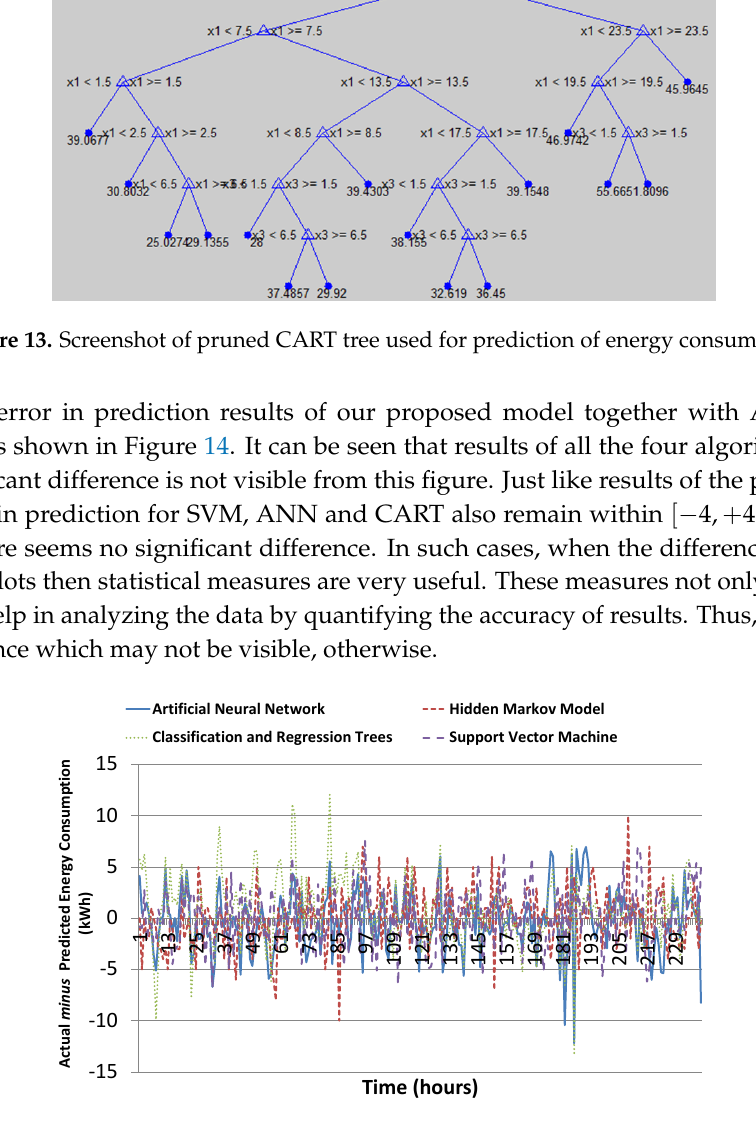
Figure 14. Error in prediction results of the proposed model, ANN, SVM and CART algorithm for 10 days hourly